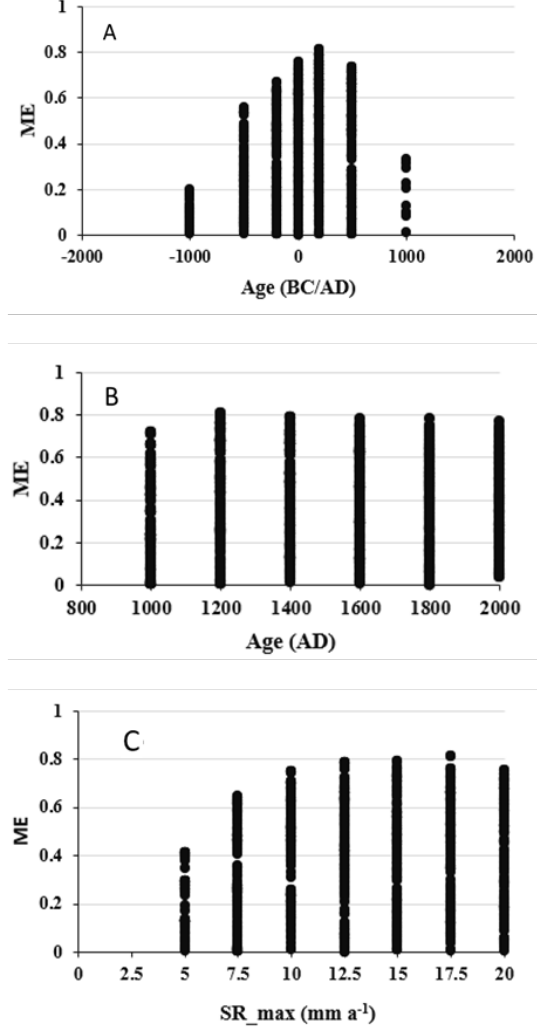
Figure 13. Model efficiency for several scenarios as a function of the ( A ) start of first sedimentation rate (SR) increase, ( B ) start of SR decrease and ( C ) height of the SR for Chencha floodplain .